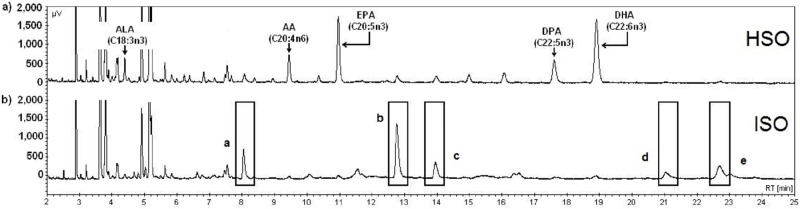
Fatty acid chromatograms of the shark oil samples.a) Hydrolyzed shark oil, HSO (shark oil before alkali-catalyzed isomerization), and b) isomerized shark oil, ISO, resulting from alkali-catalyzed isomerization.